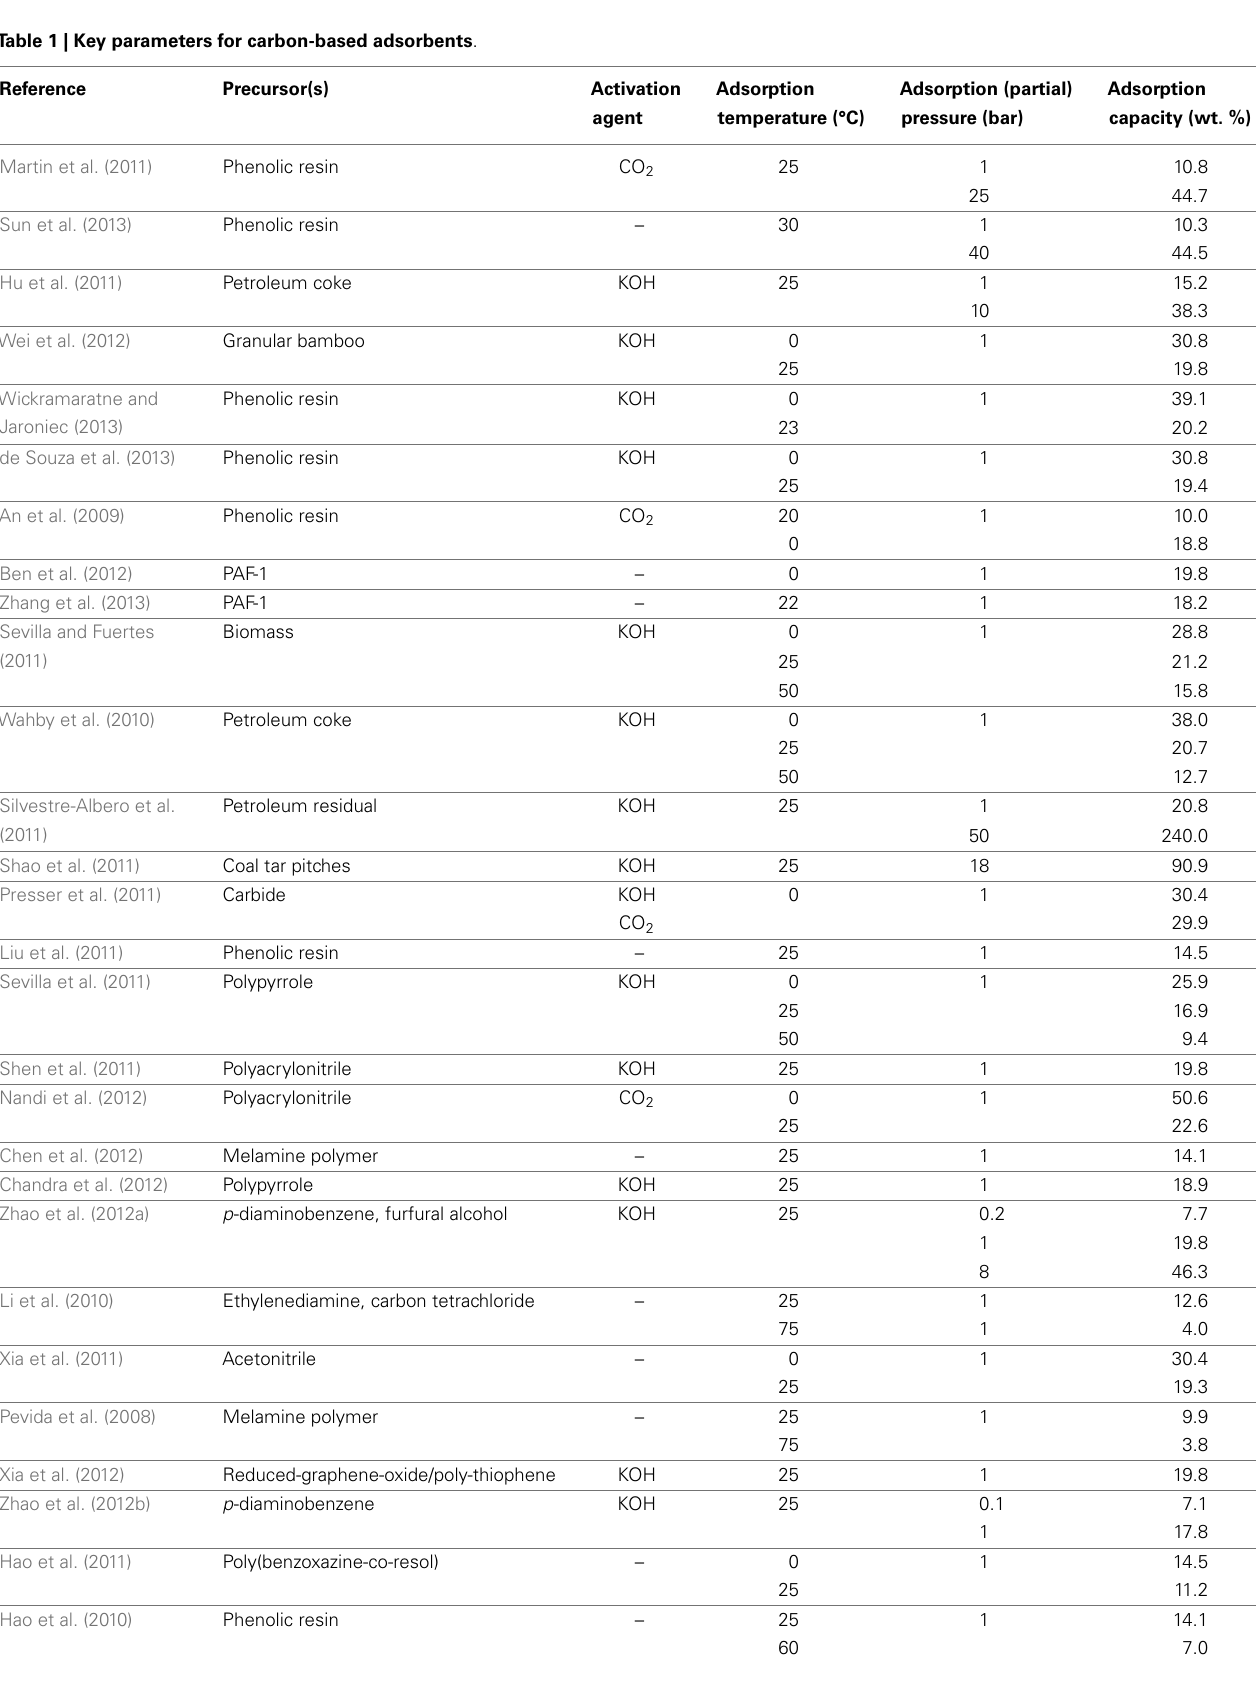
Table 1 | Key parameters for carbon-based adsorbents